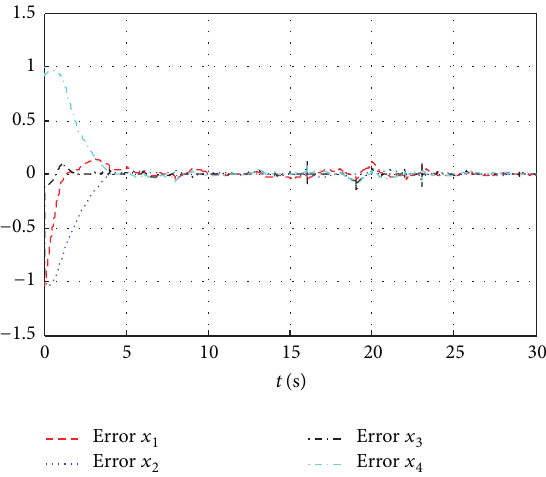
Figure 10: The errors between states and their